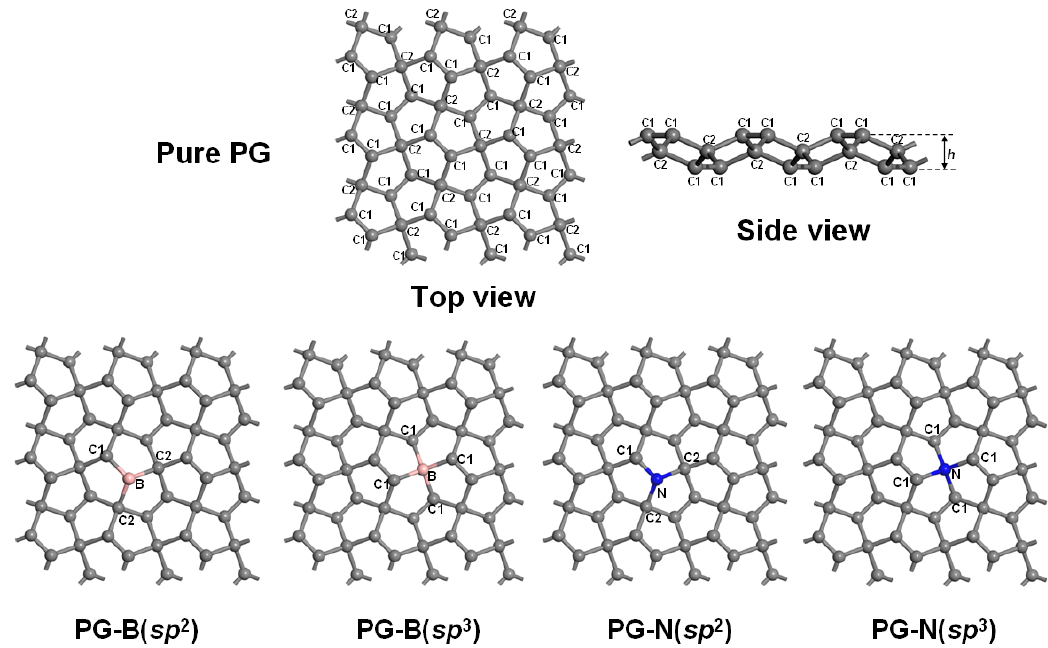
Figure 1. Structures of pristine penta-graphene (PG) and B/N-doped PG model systems. C1 and C2 represent the carbon atoms with sp 2 and sp 3 hybridization, respectively, and h is the thicknesses of the system. The gray, pink and blue balls represent the carbon, boron, and nitrogen atoms, respectively.